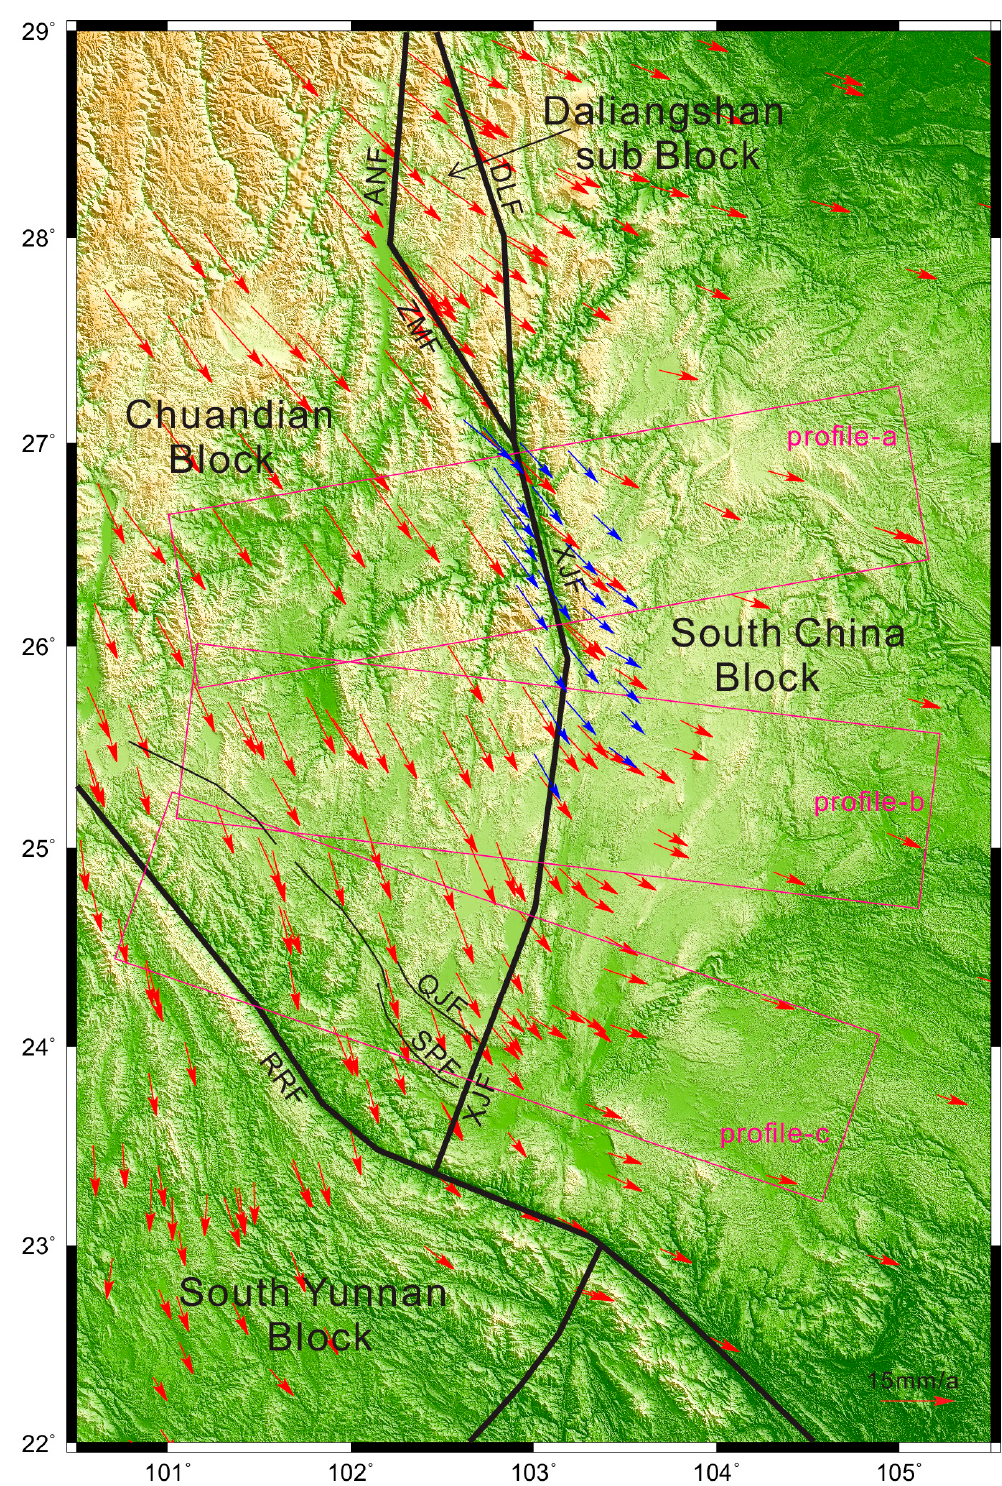
Figure 2. GNSS velocity field in the Eurasian frame and block models used in the inversion. Velocity vectors in red are from the study [26], and the velocity vectors in blue are from our near-fault obser- vations. The black thick solid lines are the block boundaries or major faults. In this study, only the Chuandian, South China, South Yunnan, and Daliangshan blocks are considered. Purple rectangles show the GNSS profiles of north, central and south segments of XJF in Figure 3. Abbreviations: QJF, Qujiang fault; SPF, Shiping